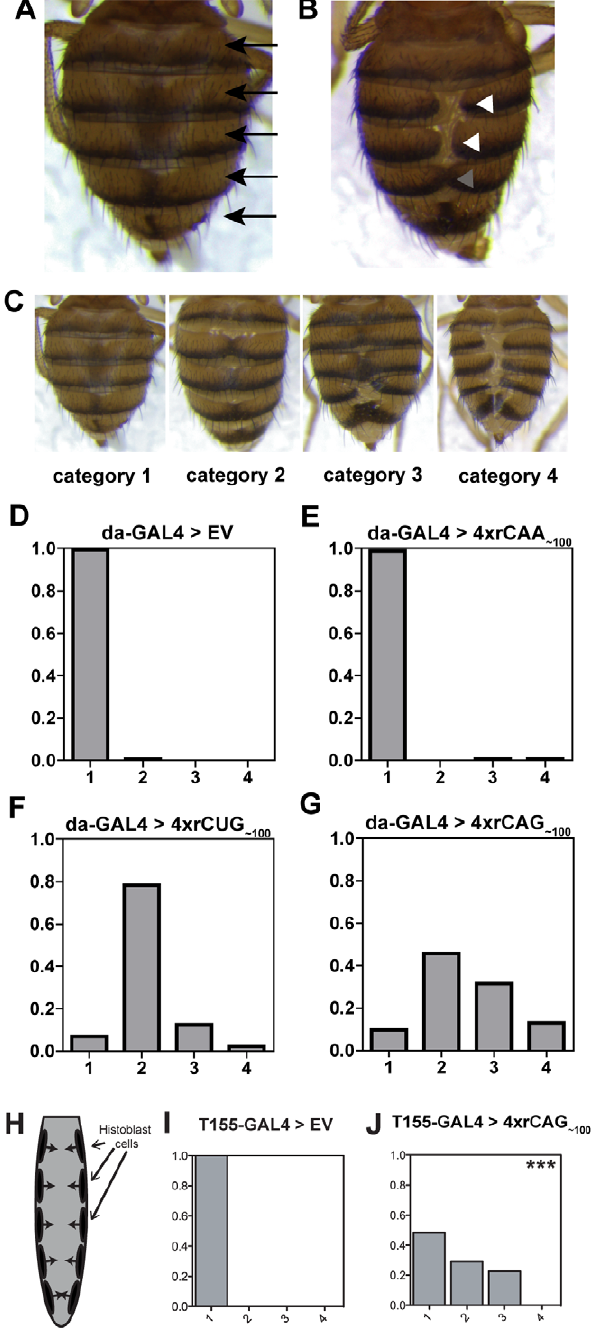
Figure 1. Tergite phenotype caused by ubiquitous expression of CAG or CUG repeat RNA in Drosophila . A , wild-type flies show a regular arrangement of tergite bands along the dorsal abdomen (arrows). B , An example of the disrupted phenotype, whereby tergites do not fuse at all (white arrowheads), or fuse only partially (grey arrowheads). C , Phenotype severity was scored on a scale of 1–4, images show typical examples from each category, where category 1 is like wildtype; category 2, tergites disrupted but not split; category 3, one tergite split; and category 4, two or more tergites split. D-E , Graphs showing the proportion of progeny within each scoring category. D , da-GAL4 driven expression of the EV control line (n=161) and, E , da- GAL4 driven expression of 4xrCAA , 100 [line 1] (n=148) gives no phenotype with almost all progeny like wild-type. F , da-GAL4 driven